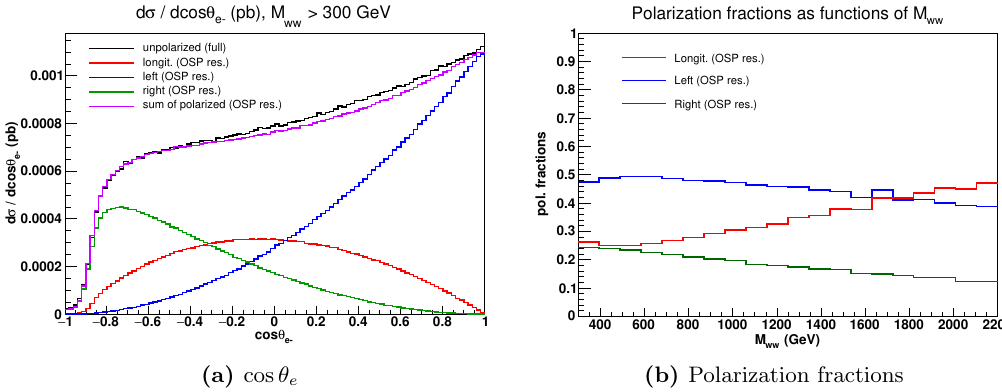
Figure 7. cos (cid:18) e distribution (left) and polarization fractions as functions of M WW (right) in the Higgsless model. p e > 20 GeV, j (cid:17) e j < 2 : 5. t